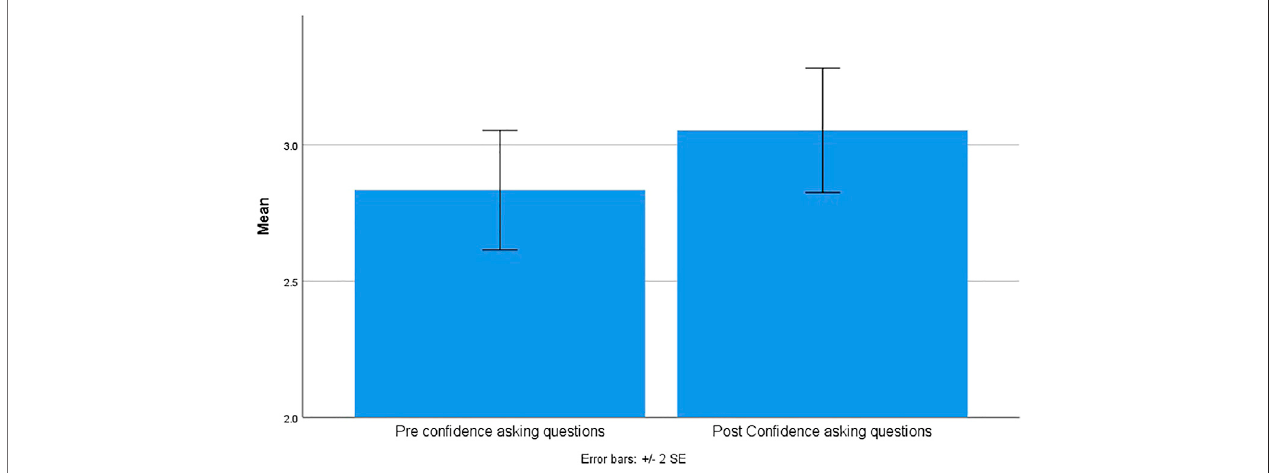
FIGURE 7 | Change in con fi dence about asking safety related questions, higher after going through the game.